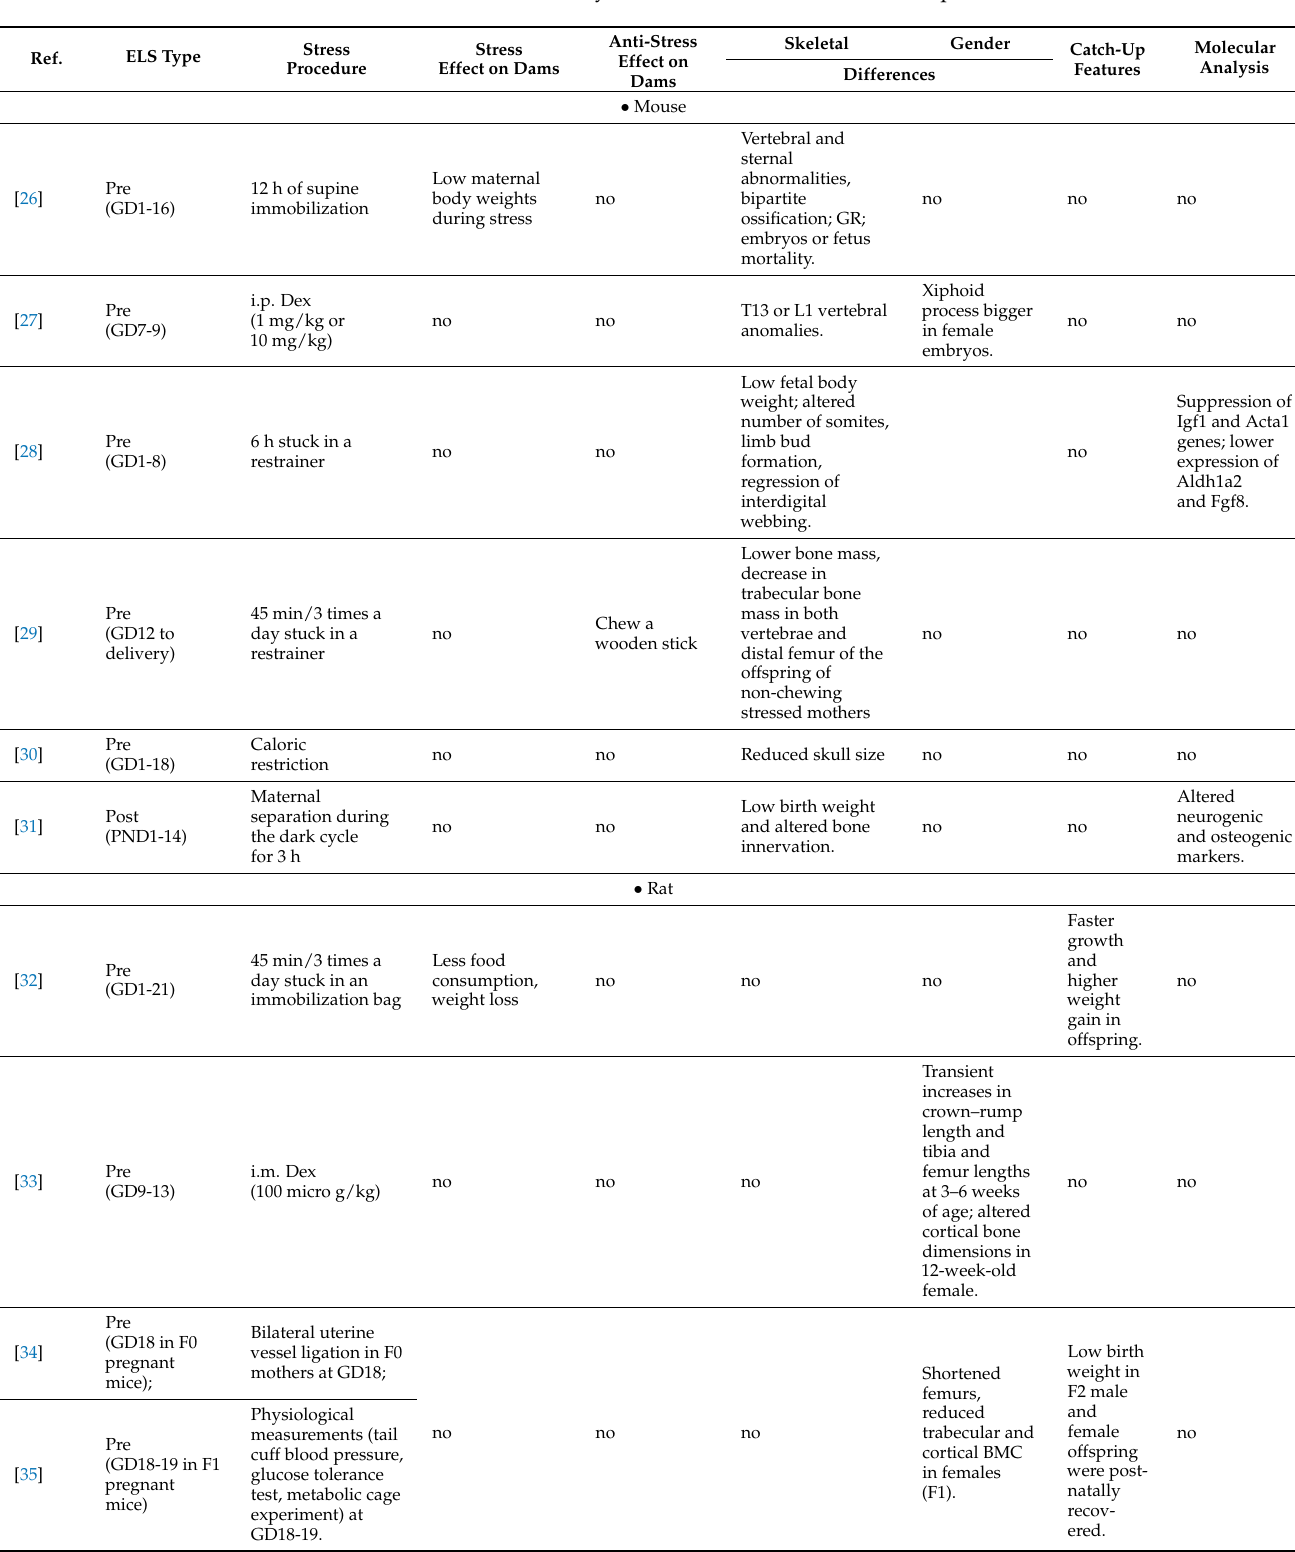
Table 1. Main features analyzed in ELS studies of bone development included in the